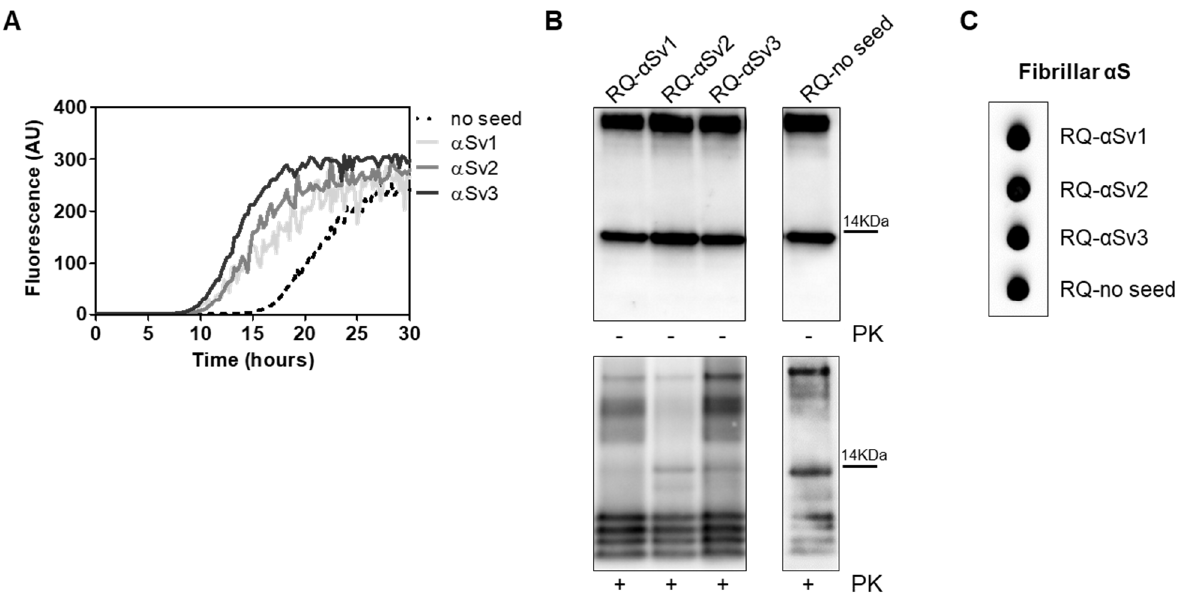
Figure 5 . ( A ) α Syn_RT-QuIC analysis of α Sv1, α Sv2 and α Sv3. Minute amounts (1.5 ag) of α Sv1, α Sv2 and α Sv3 were tested in α Syn_RT-QuIC and induced an efficient seeding activity, with respect to the control (no seed). Curves represented in the graph were obtained by plotting the average fluorescence intensities of each sample against time. ( B ) Western blot analysis of untreated or PK digested α Syn_RT-QuIC products, collected at 30 h. RQ- α Sv1, RQ- α Sv2, RQ- α Sv3 and RQ-no seed showed similar signal intensities before digestion. After PK treatment, all samples showed similar resistance to digestion and comparable biochemical profiles (AS08 358 antibody). Number on the right indicates the molecular weight. ( C ) Dot blot analysis of α Syn_RT-QuIC products, collected at 30 h. Dot blot analysis performed using the MJFR antibody showed the presence of a strong signal in all samples.